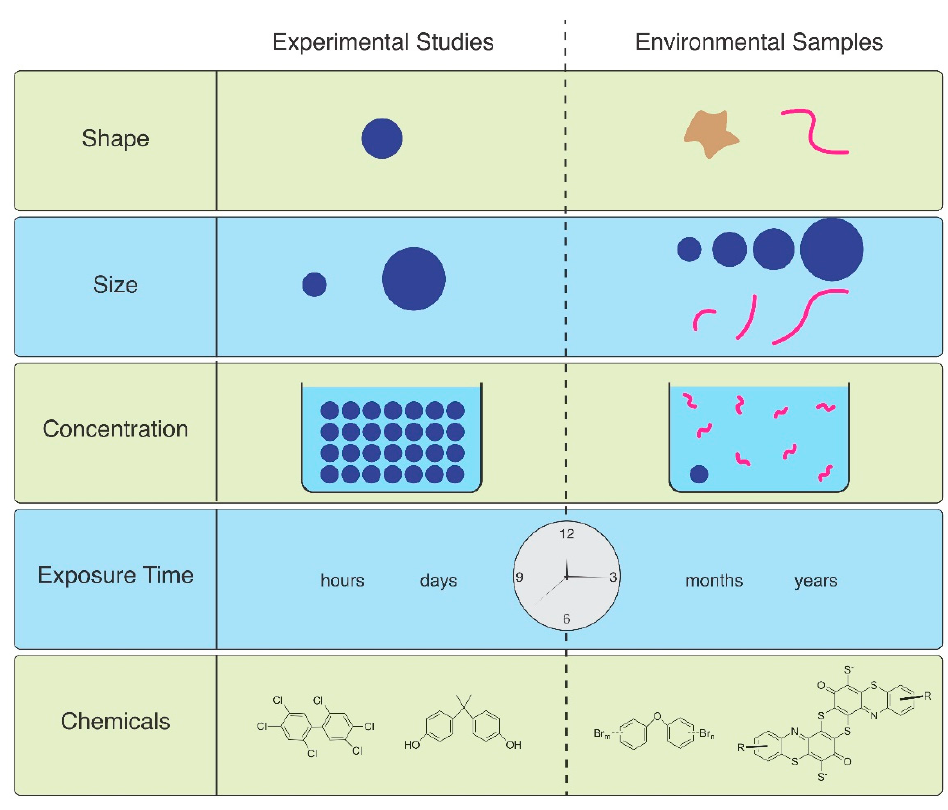
Figure 2. Mismatch between environmental microplastics used in experimental studies and those in environmental samples. From Weis and Palmquist 2021 [16]. Open Access.